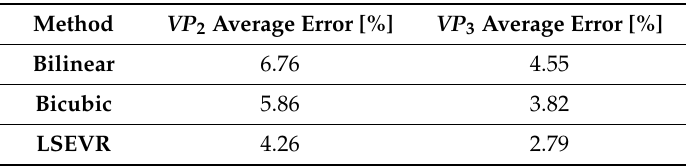
Table 3. Assessment of accuracy for VP 2 and VP 3 .